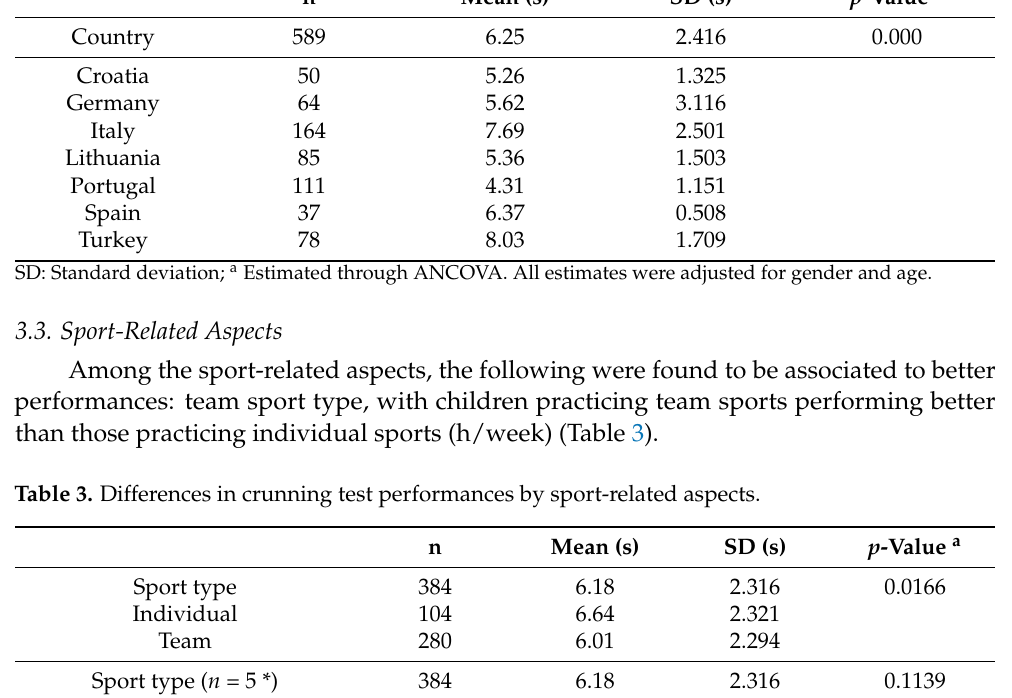
Sport frequency (h/week)